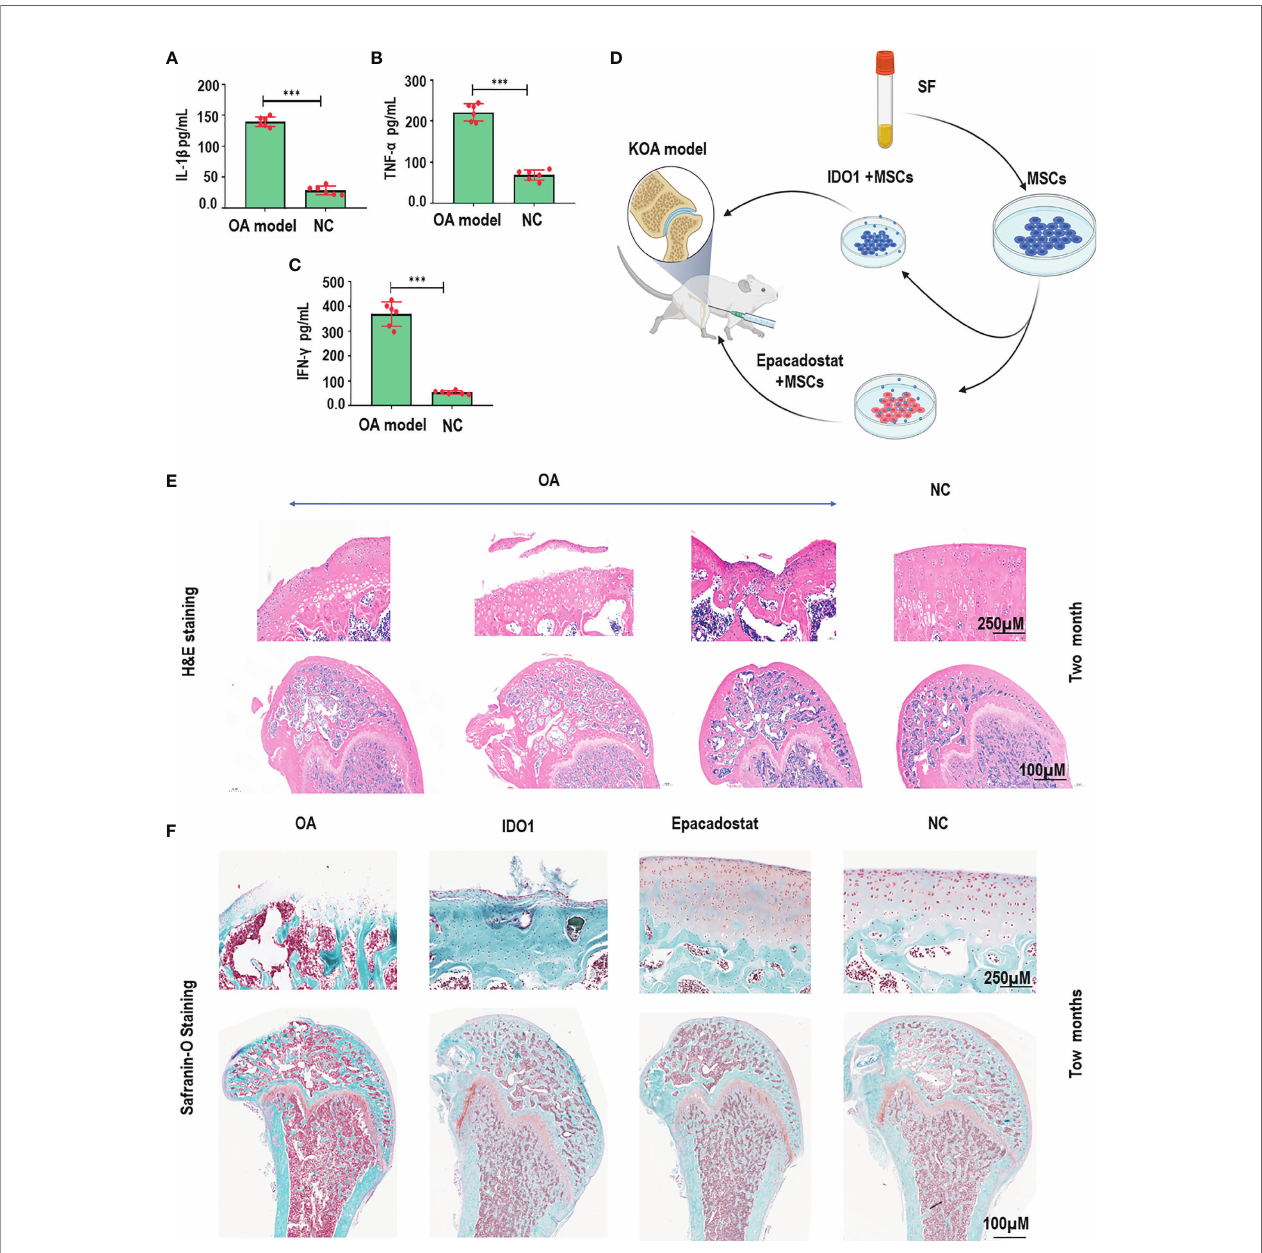
FIGURE 1 | IDO1 inhibitor mixed with MSCs improved the ef fi cacy of MSCs to promote cartilage regeneration inOA animal model. (A) The levelsofIL-1 b in theOA animal model after one month of model establishment compared to normal control. (B) The levels of TNF- a inthe OA animal model after one month of model establishment compared to normal control. (C) The levels of IFN- g inthe OA animal model after one month ofmodel establishment compared to normal control. (D) The schematic diagram presentedthe performedstrategyfor stimulatedMSCs to beused in the cartilage repair for the OA model. (E) HE staining for knee joints of OA animal model after one month that presented the initiation ofcartilage degeneration comparedto normal control groups. (F) Safranin-O staining for the cartilage of OA model after two monthsof treatment with Epacadostat-treated MSCs, IDO1-treated cells, without treatment group, normal control group. *** p < 0.001 vs NC